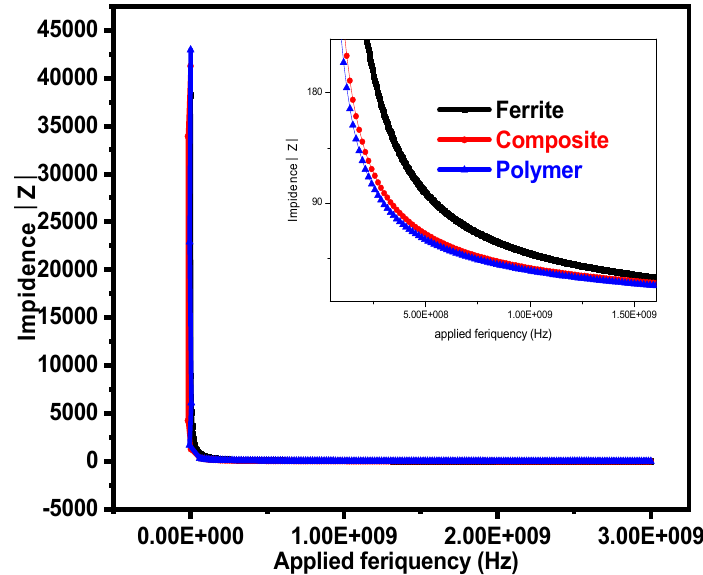
Figure 7. The plot of impedance vs. frequency of Y-type hexaferrite Sr 2 Co 2 Fe 12 O 22 , composite (Sr 2 Co 2 Fe 12 O 22 + PPy-DBSA) and polymer PPy-DBSA.